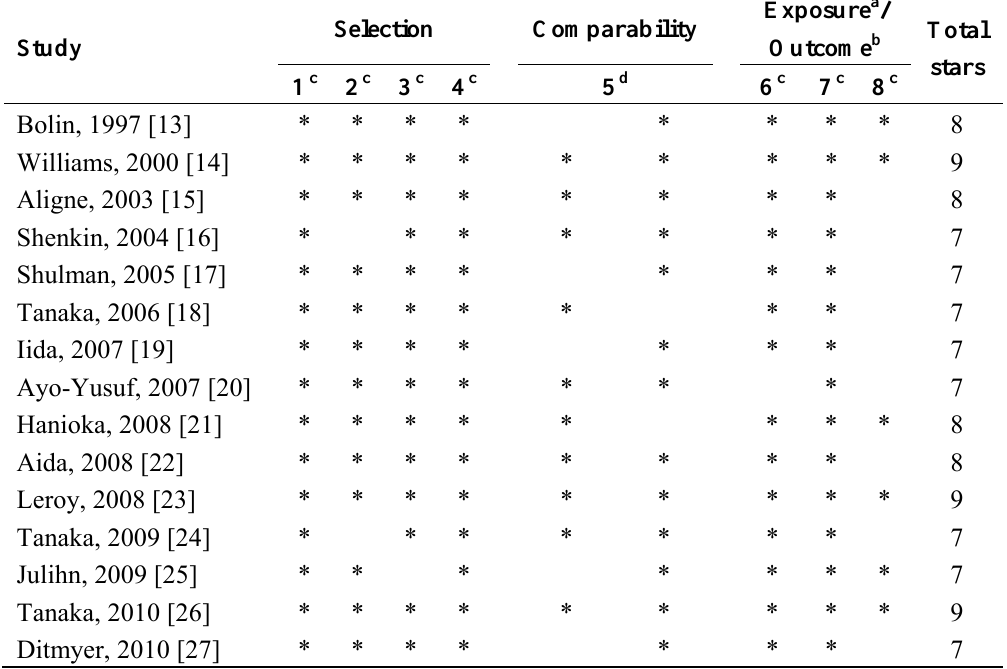
Table 2. Methodological quality assessed using the modified NOS. Study